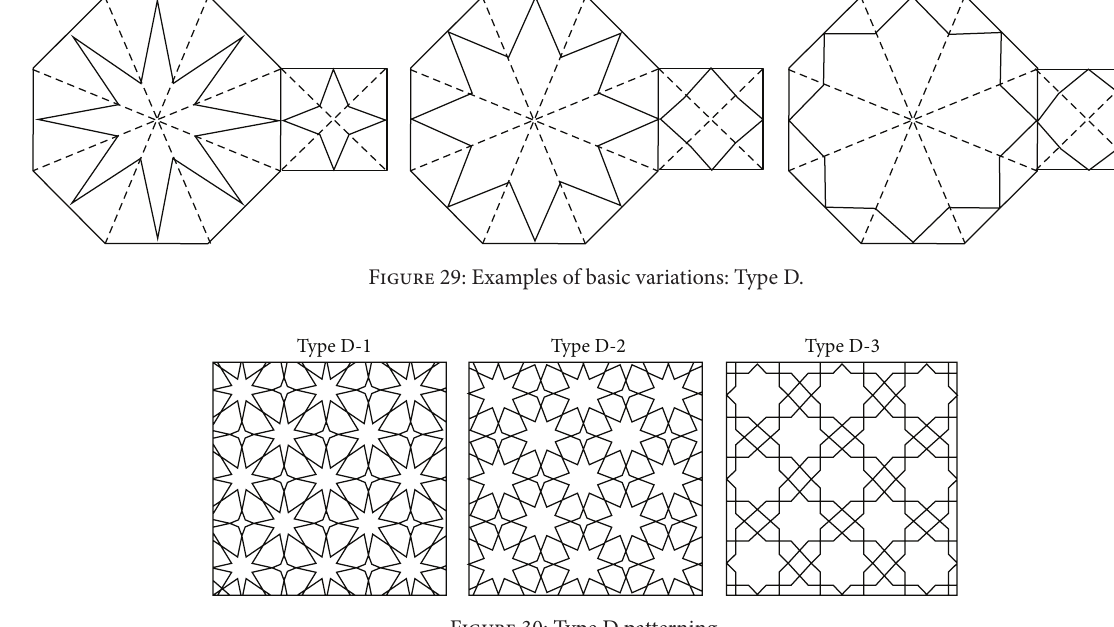
Figure 30: Type D